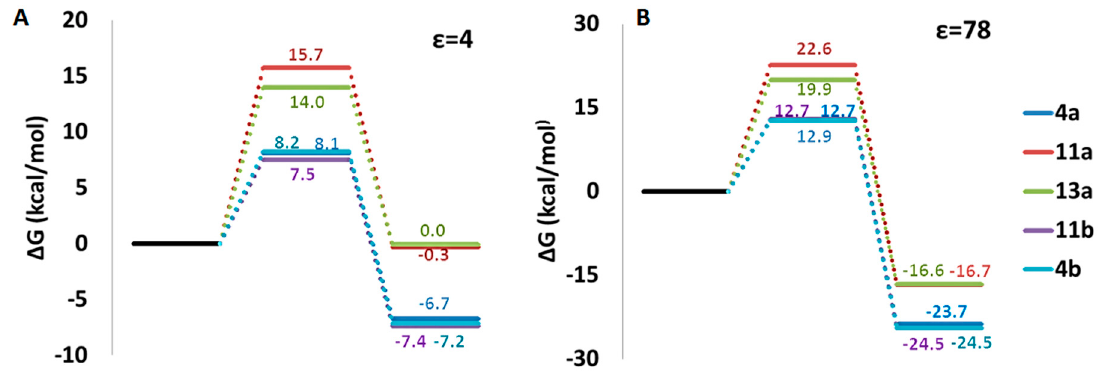
Figure 3. B3LYP/6-311++G** potential energy profiles in an apolar ( A ) and in water ( B ) solvents for HAT process from Vam3 to ·OOH free radical.